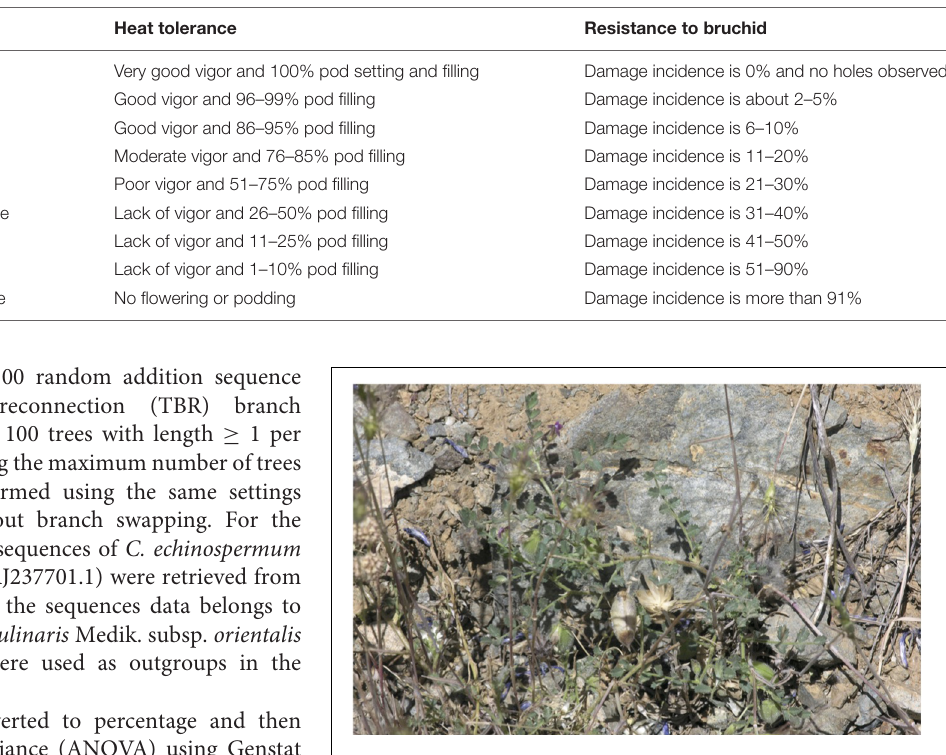
FIGURE 2 | C. turcicum in situ at Yedipinar collection site, Sivrice district, Elazig province, Turkey on 12th June 2015. Specimen is both flowering and podding, with some mature pods.